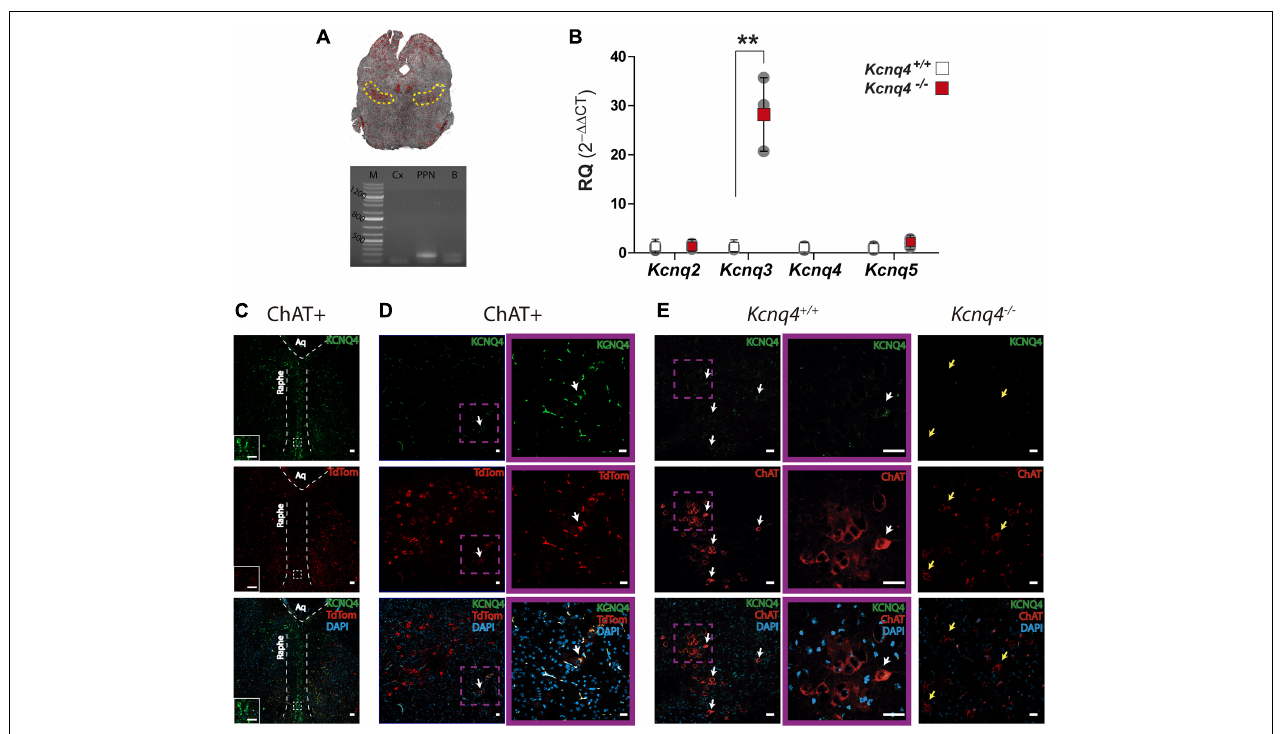
FIGURE 2 | KCNQ subunits expression in the PPN. (A) Top : Confocal image of a coronal midbrain slice (–4.60 mm from bregma), showing the location of the PPN determined by ChAT labeling (yellow dashed line) , which corresponds to the area where tissue samples were collected. Bottom : Agarose gel showing PCR band corresponding to ChAT expression. M : molecular weight marker, Cx : brain cortex (negative control), PPN : sample containing the PPN, B: whole brain (positive control). (B) Relative quantification (RQ) of mRNA expression for each subunit from WT (white) and KO (red) mice. The fold change of each subunit was calculated using 2 − (cid:49)(cid:49) Ct . Data represented as mean ± SD ( n = 3). Student’s t -test; ** p = 0.0028). (C) Brain coronal section of a ChAT-tdTomato mouse midbrain showing KCNQ4 staining in the raphe nucleus. The inset is a higher magnification of the section delimited by the white square with dashed line . Scale bar : 50 µ m in both pictures. (D,E) KCNQ4 immunofluorescence on coronal brain sections of ChAT-tdTomato (ChAT+; D ), WT ( Kcnq4 + / + ; E ), and KCNQ4 KO mice ( Kcnq4 − / − ; E ). Both models revealed that only a subpopulation of PPN cholinergic neurons located on the external limits possess KCNQ4 (white arrows) . Higher magnification of KCNQ4-positive neurons (purple square) . KCNQ4 could not be detected on PPN cholinergic neurons in KO animals (yellow arrows) that confirmed the specificity of the antibody. Upper panel : KCNQ4 (green) . Middle panel : ChAT immunolabeling or tdTomato expression under ChAT promoter (red) . Bottom panel : Merged image with DAPI. Scale bar: 20 µ